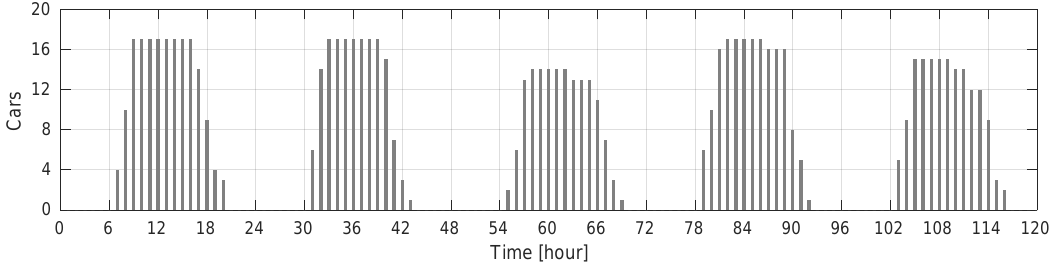
Figure 4. Multistory carpark occupancy on a week